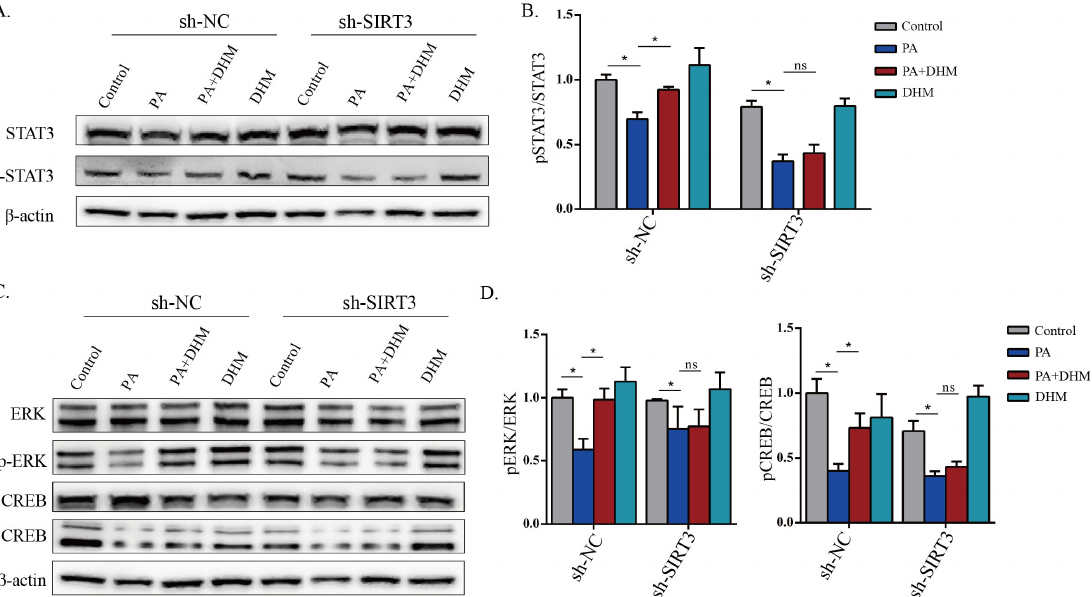
Figure 5. DHM stimulated STAT3 activation through SIRT3 in MNK3 cells via ERK ‐ CREB signaling. ( A , B ) Representative immunoblots of STAT3 and p ‐ STAT3 in the indicated groups, and quantitative graphs show the ratios of p ‐ STAT3/STAT3. ( C ) The protein expression levels of ERK, p ‐ ERK, CREB, and p ‐ CREB in the indicated groups were detected using Western blotting. ( D ) Quantitative graphs show the ratios of p ‐ ERK/ERK and p ‐ CREB/CREB. * p < 0.05; ns, non ‐ significance as determined by one ‐ way ANOVA followed by the Tukey–Kramer post hoc test.